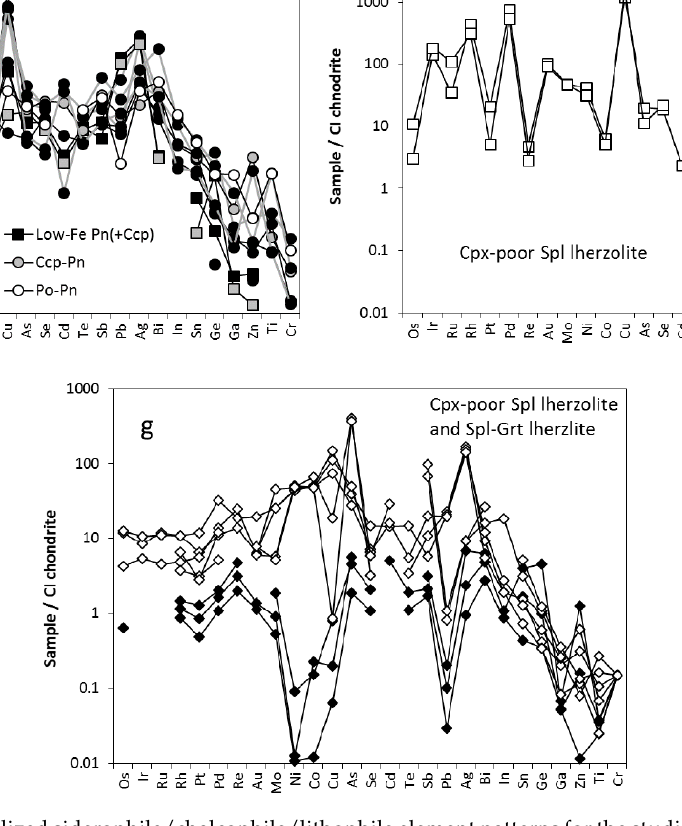
Figure 8. CI chondrite-normalized siderophile/chalcophile/lithophile element patterns for the studied sulfides (CI chondrite element concentrations are after Anders and Grevesse [41]). Diagrams are grouped according to the sulfide types identified on the basis of the PGE systematics (see Figure 7). ( a ) Unmetasomatized residual sulfides of the e- and i-types from Cpx-rich Spl lherzolites and Spl-Grt lherzolites. Peaks at Cu and Ag are observed for sulfides displaying mixed spectra, i.e., Pn-Ccp (see text for more details); ( b ) residual sulfides of the e-type in Cpx-poor Spl lherzolite and Cpx-rich Spl lherzolite. Peaks at Cu and Ag are observed for sulfides displaying mixed spectra (Pn-Ccp). Monomineral Pn does not display a peak at Cu, but it is still enriched in Ag; ( c ) melt-like (see Westner et al. [27]) sulfides of the i- and e-types that display unfractionated PGE patterns; all such melt-like sulfides display mixed spectra; ( d ) melt-like sulfides of the i- and e-types from all lherzolite types (most analyzed sulfides belong with this group) that display mixed but not significantly fractionated PGE patterns; ( e ) melt-like sulfides of the i-type that display the P-PGE as being significantly over the I-PGE in the PGE patterns. Sheer Pn and Pld do not display a peak at Cu, but they are still enriched in Ag; ( f ) Cu-Ni mss in Cpx-poor Spl lherzolite (no data on Ti and Cr are available); ( g ) partly incomplete patterns for m-type sulfides. Py displays generally unfractionated patterns complicated by troughs at Ni, Co, Cu, and Pb and subchondritic concentrations of Ti and Cr. Co-Vo is enriched in siderophile elements and is depleted in lithophile elements. Markers are as seen in Figure 7. Grey lines are for Pn-Ccp (see text for more details).